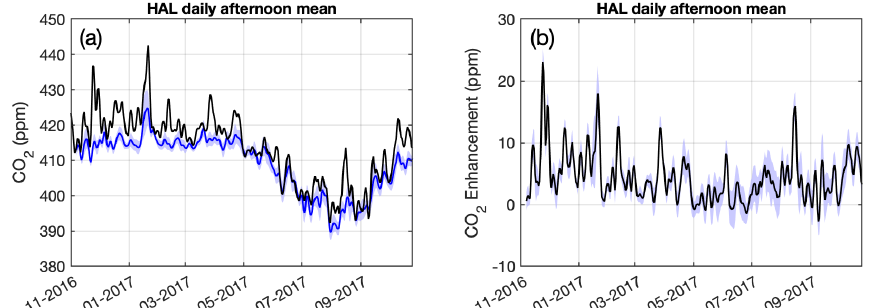
Figure 9. (a) Observed CO 2 time series at HAL for 1 year (black) with the background (blue) as the mean of five backgrounds from Table 1. (b) Corresponding CO 2 enhancement time series. We note that in summer the enhancements can be small or even negative, because they represent the impact of both positive (anthropogenic and biogenic) and negative (biogenic) fluxes in the urban domain. In both panels, lines are the 7d moving average of mid-afternoon daily means; blue shading indicates the standard deviation of the five backgrounds.